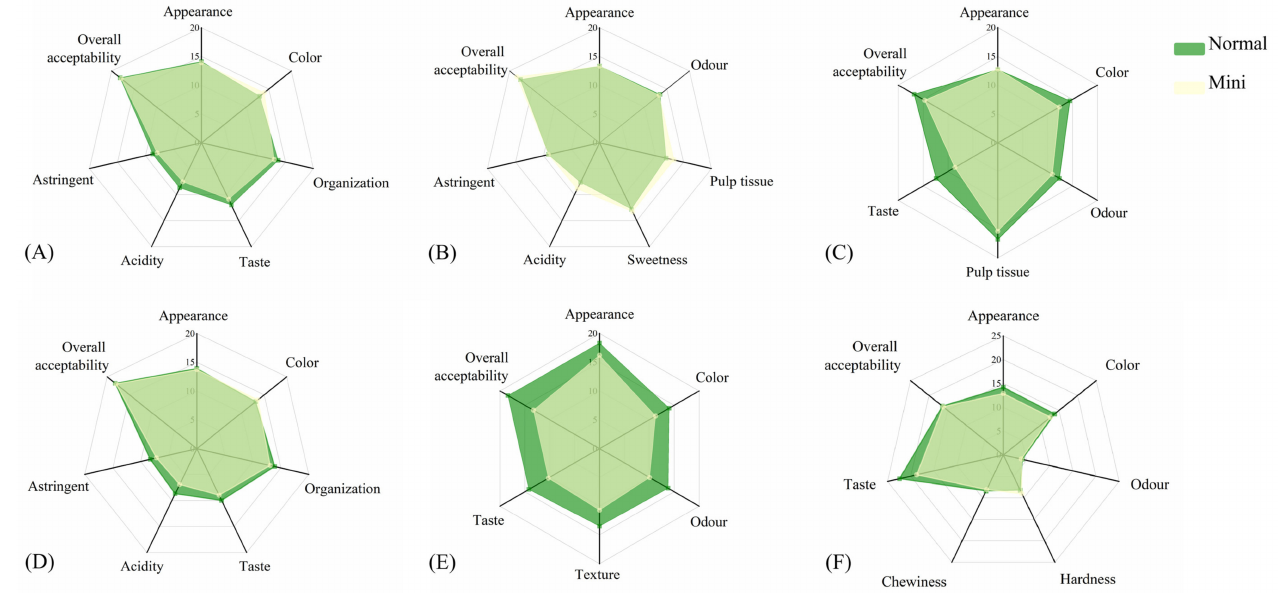
Figure 5. Artificial sensory evaluation of MFV and NFV: ( A ) watermelon; ( B ) pineapple; ( C ) pumpkin; ( D ) cabbage; ( E ) maize; ( F ) carrot.